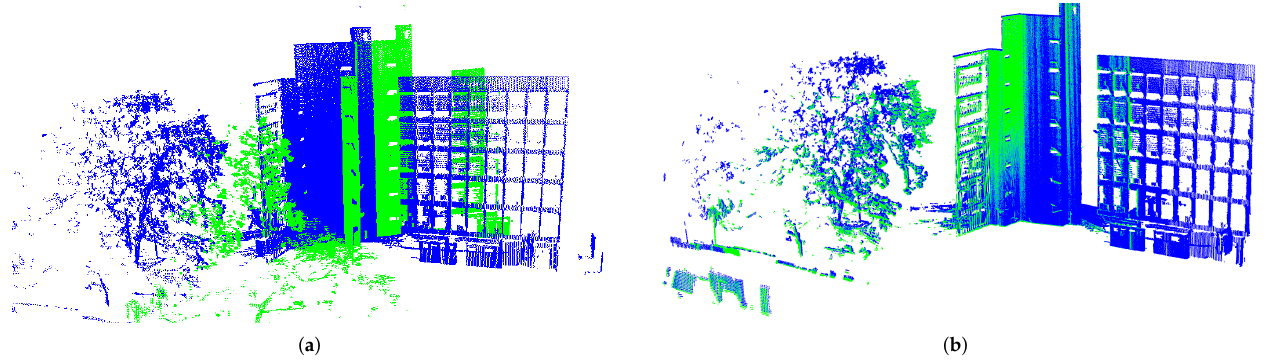
Figure 14. UFC scene alignment under different viewpoints and densities. ( a ) Generalized ICP.